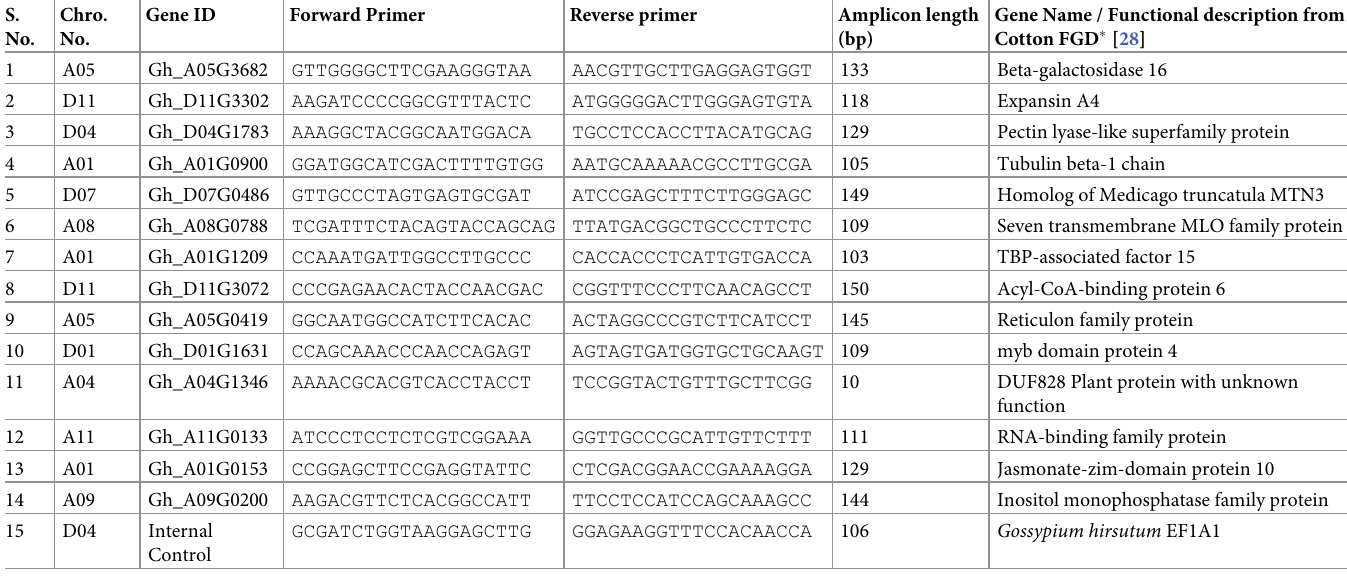
Table 1. Primer sequences of genes used for validation study using qRT-PCR.